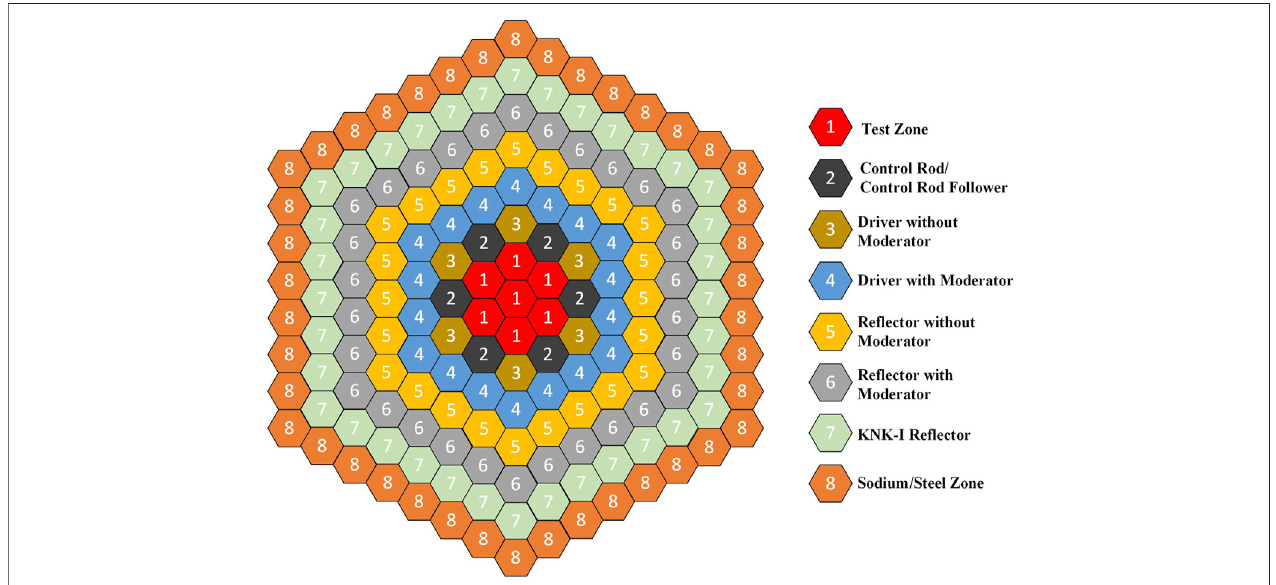
FIGURE 3 | Radial layout of the small fast reactor core.